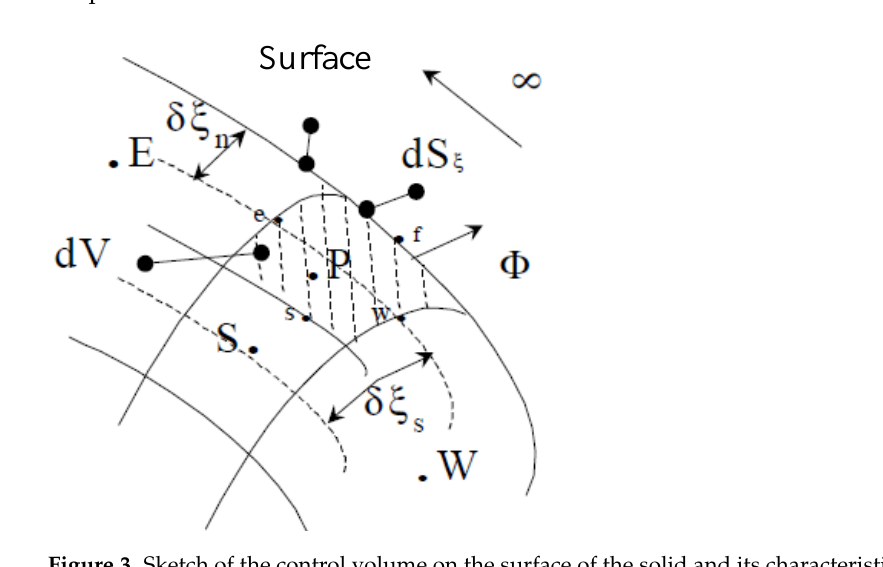
Figure 3. Sketch of the control volume on the surface of the solid and its characteristic dimensions.